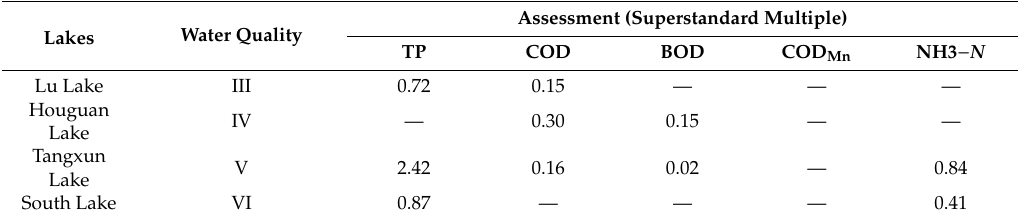
Table 1. Water quality data of the major lakes in Wuhan.